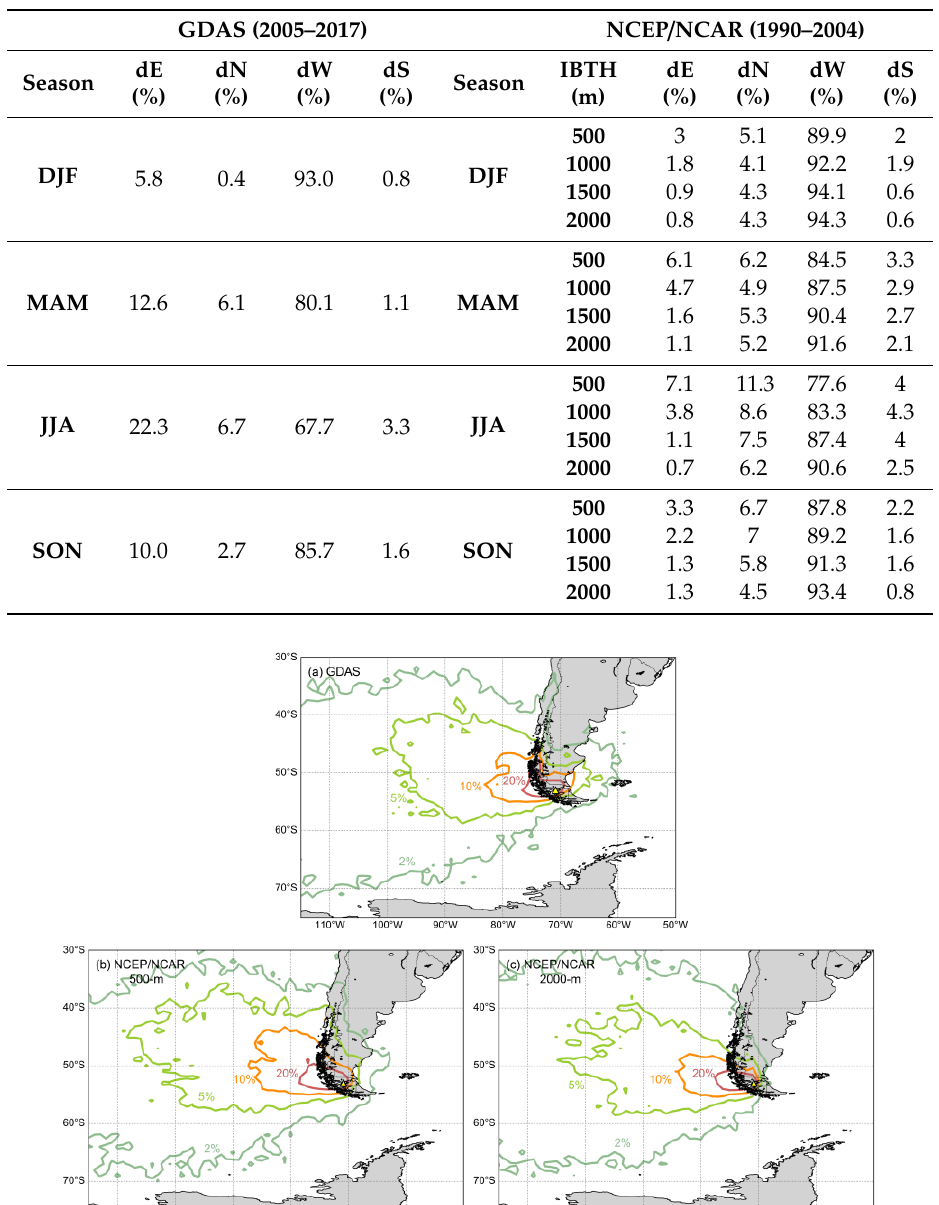
Table 1. Mean monthly proportions of precipitation in Punta Arenas derived from di ff erent trajectory clusters in the Hybrid Single-Particle Lagrangian Integrated Trajectory (HYSPLIT) framework for di ff erent seasons. Results from the NCEP / NCAR reanalysis dataset are shown for di ff erent initial back-trajectory heights (IBTH).